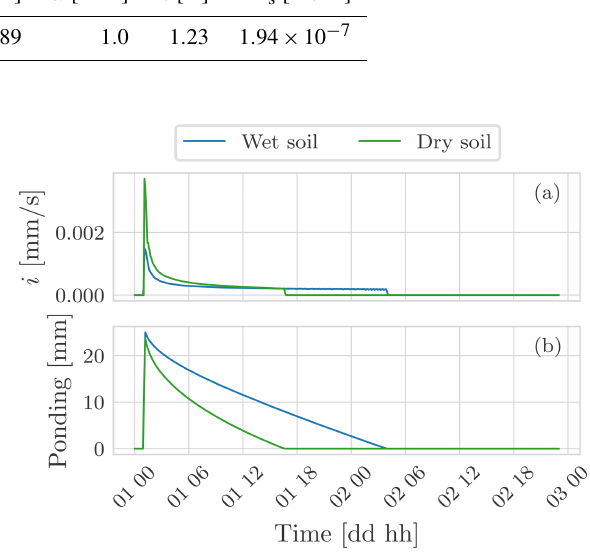
Figure C7. (a) A comparison between the infiltration rate for two cases: wet and dry initial condition. In the dry case, soil infiltration is greater than the wet case even though the hydraulic conductivity is smaller. This is due to the higher capillary gradients that develop in the soil. (b) The time evolution of the water ponding at the soil